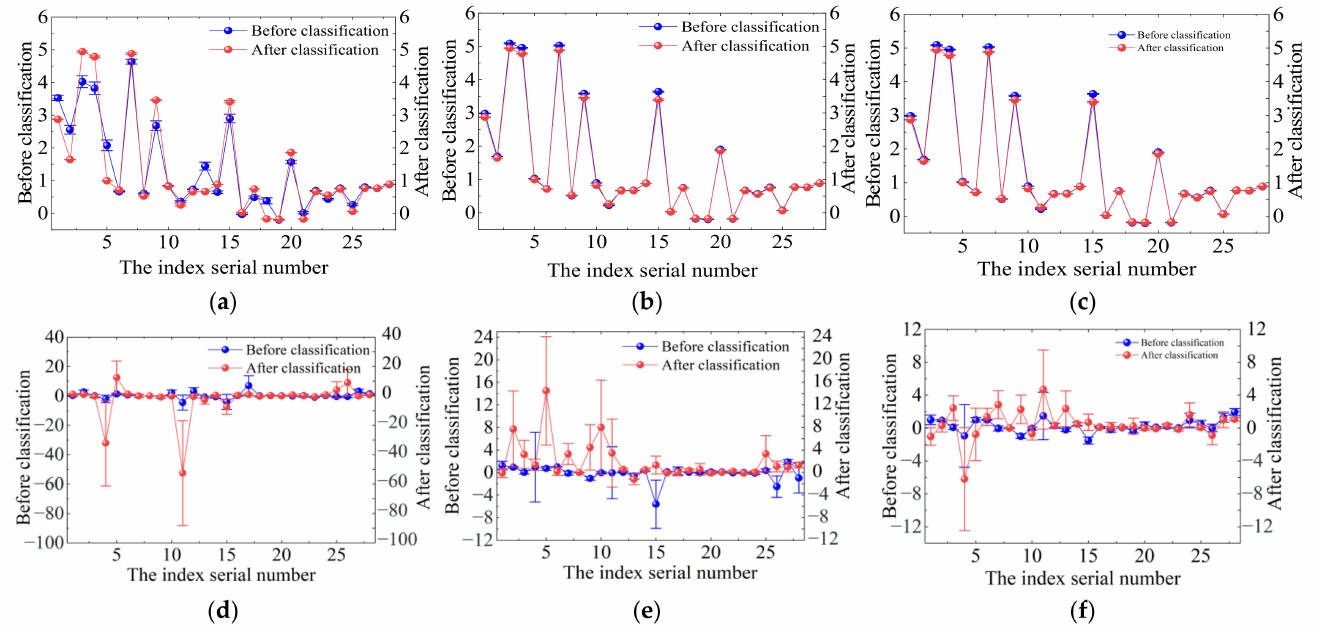
Figure 11. Change trend of some indexes before and after image pixel classification (60 m): ( a ) the original spectrum and after Gaussian filtering ( b ), after Gaussian filtering and then SG filtering ( c ), using the standard normal variate (SNV) method ( d ), after Gaussian and then SNV ( e ), and after successive Gaussian filtering, SG filtering, and SNV ( f ). The labels refer to the same for processing in Figures 12 and 13 for heights of 80 and 100 m, respectively.